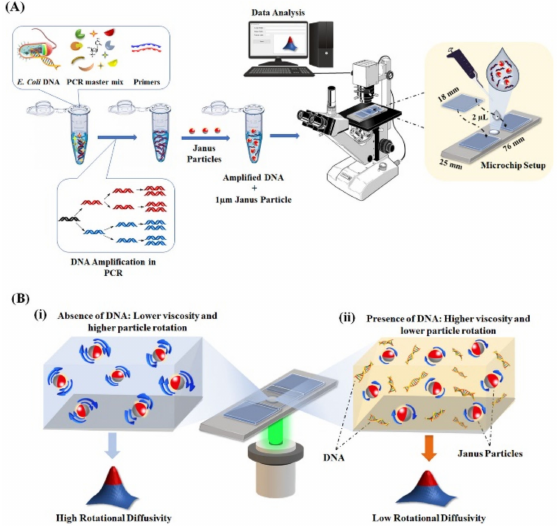
Figure 16. ( A )Schematic illustration of the rotational diffusometry experimental setup. ( B ) Rep- resentative of rotational diffusometry (RD) in a microfluidic device with modified Janus particles. (i) In the absence of DNA, the Janus particles show higher rotational Brownian motion with a faster blinking signal. (ii) In the presence of DNA, the solution viscosity increases, which leads to a lower rotational Brownian motion of the particles and slower blinking signals. Reprinted with permission from ref. [191]. Copyright © 2021 American Chemical